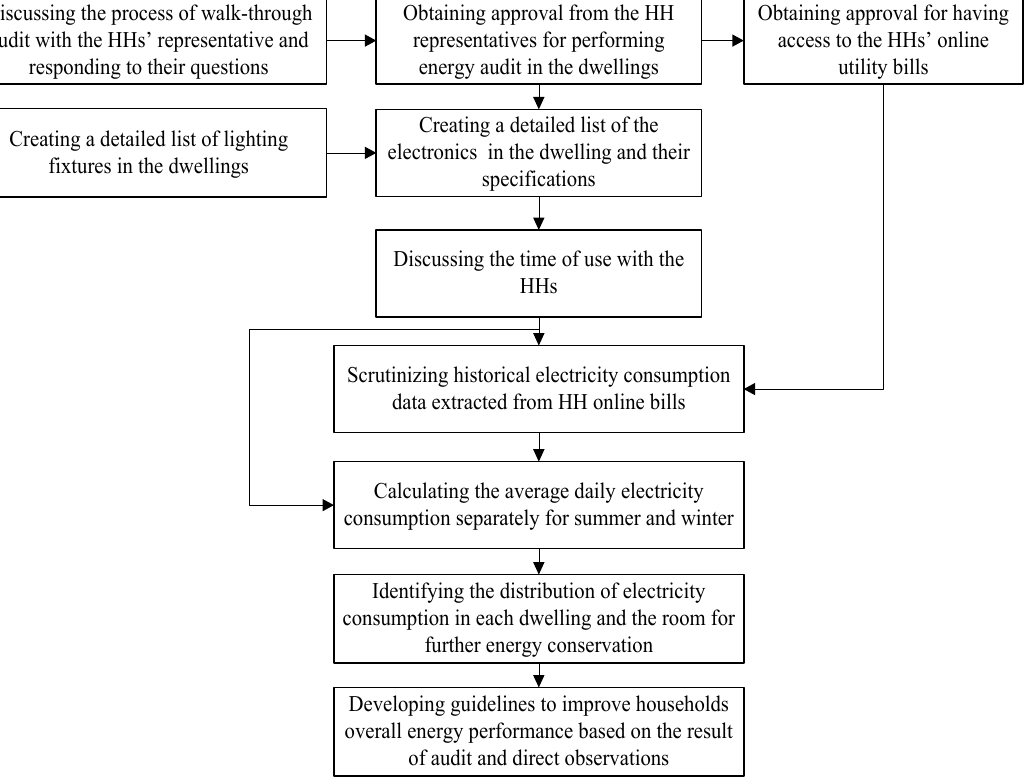
Fig. 2. Methodology fl